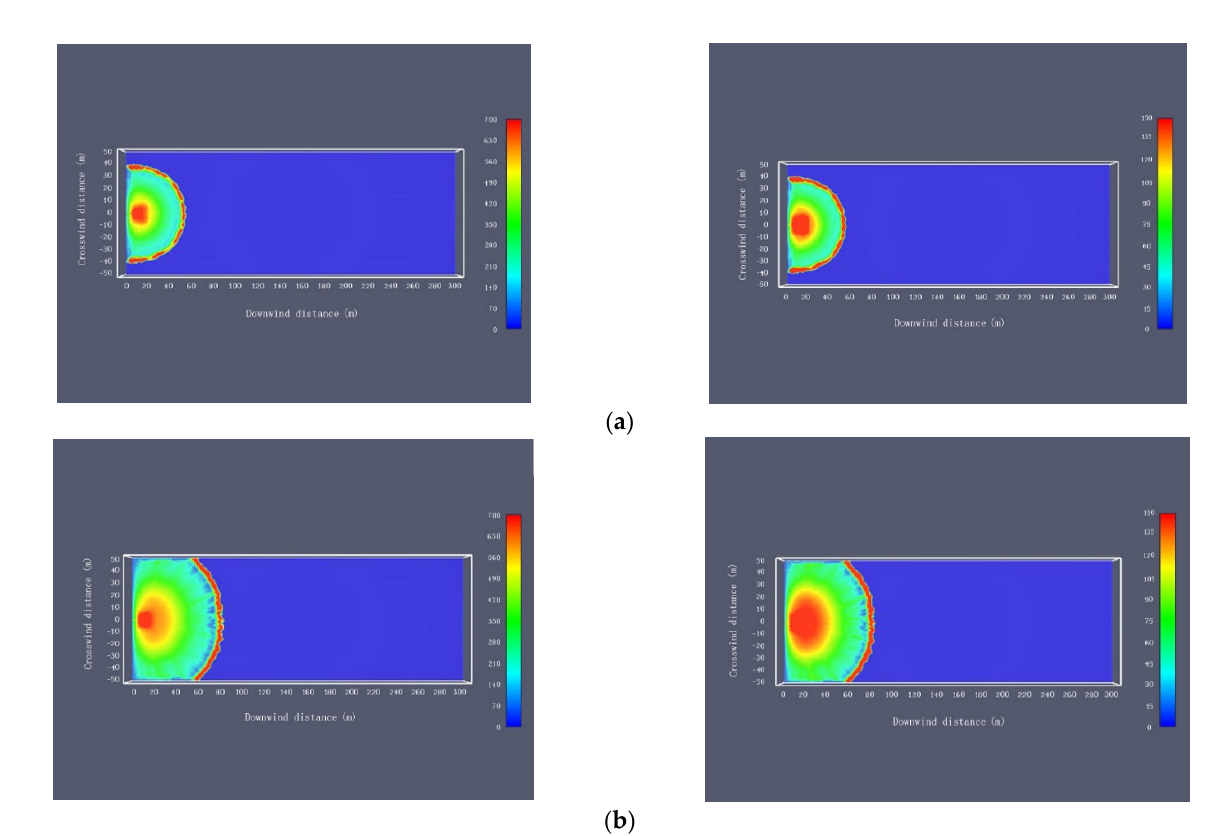
Figure 5. Z-plane (H = 2 m) diffusion concentration area distribution map when the atmosphere is unstable (top view). ( a ) Concentration distribution of vinyl chloride (left) and formaldehyde (right) at t = 60 s. ( b ) Concentration distribution (ppm) of vinyl chloride (left) and formaldehyde (right) at t = 120 s.